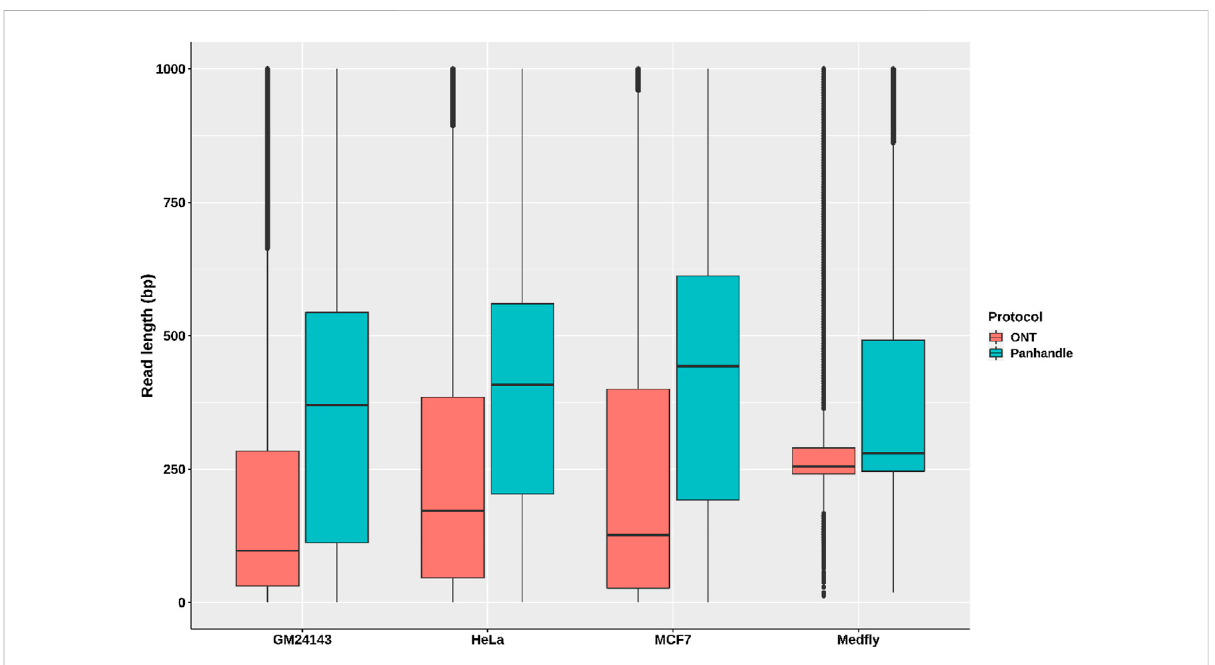
FIGURE 3 Readlengthdistributions.Passreads(readswithPhredscoreof9andabove)from4samplesprocessedbothwithONTprotocol(SQK-PCB109, OxfordNanoporeTechnologies)andoutin-houseprotocolcalledPanhandleweretrimmedofalladaptersandpoly(A)tails.Theboxplotshowstheir read length